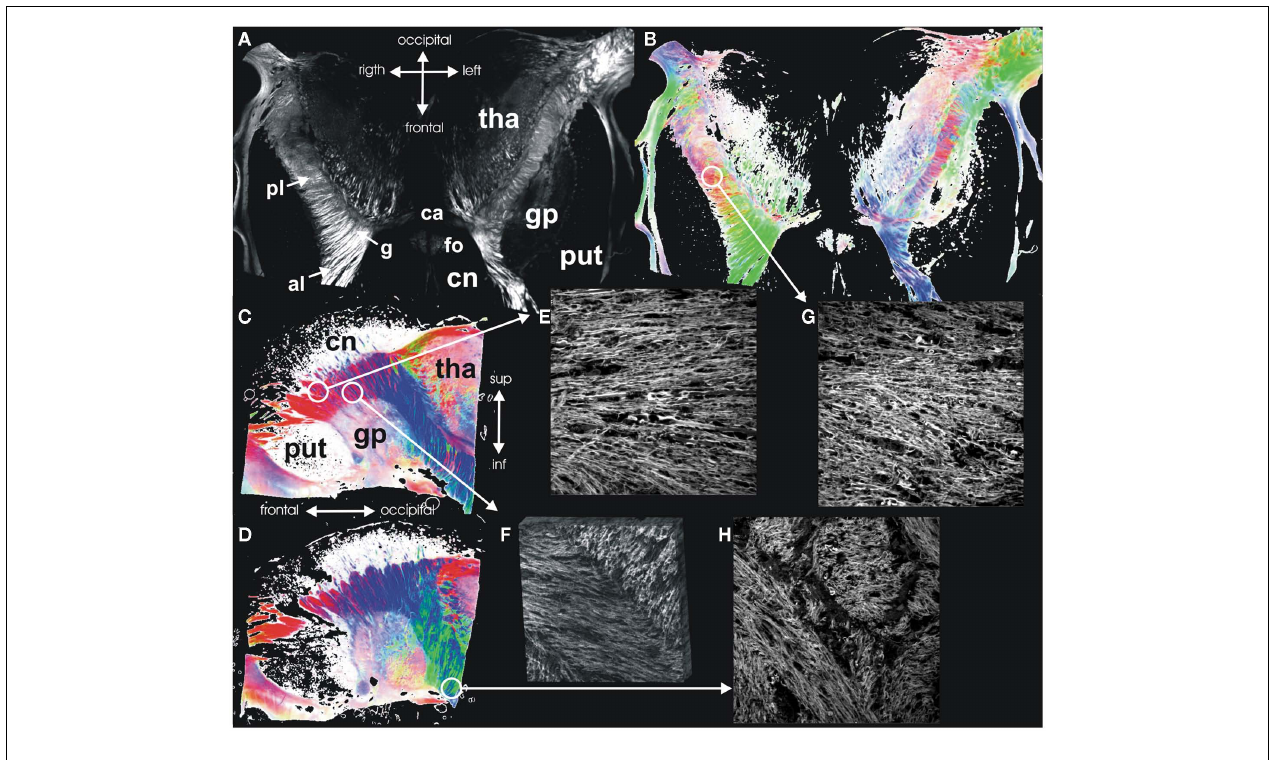
anterior thalamic radiation and the frontopontine fiber bundles (3D reconstruction), (G) posterior limb with intermingling fiber bundles from the pyramidal tract and superior thalamic radiation, (H) sublentiform part with larger intermingling compact bundles of fibers. Abbreviations: pl, posterior limb; g, genu; and al, anterior limb of the internal capsule; ca, anterior commissure; fo, fornix; gp, globus pallidus; pt, putamen; cn, caudate nucleus; tha,